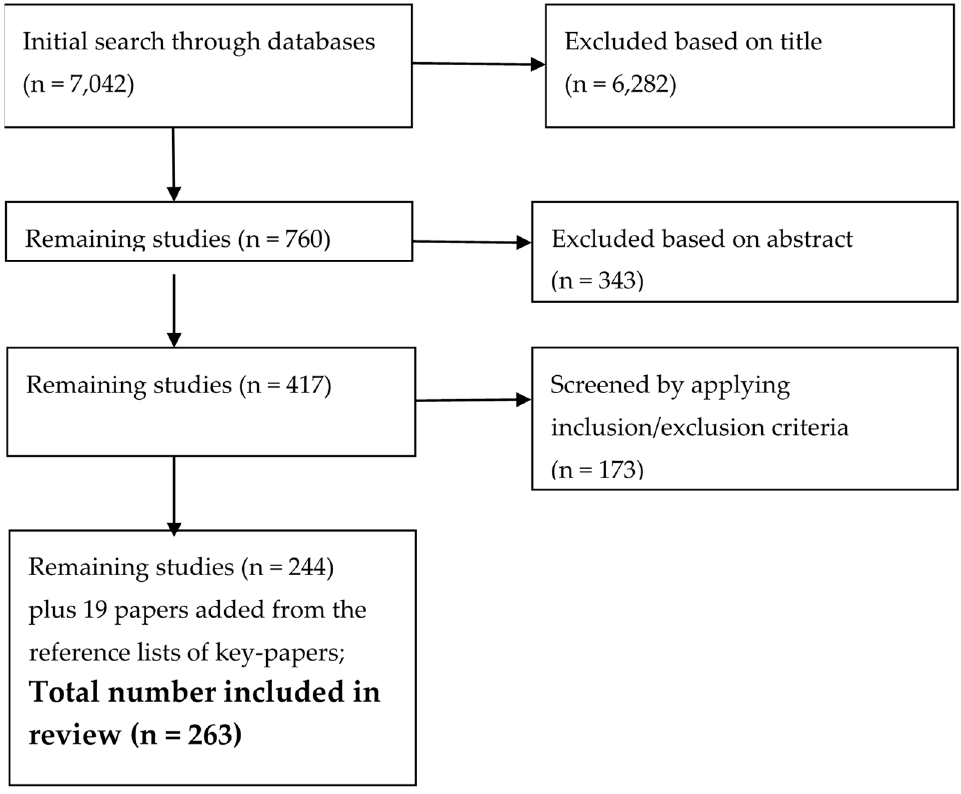
Figure 1. Article screening and selection process.